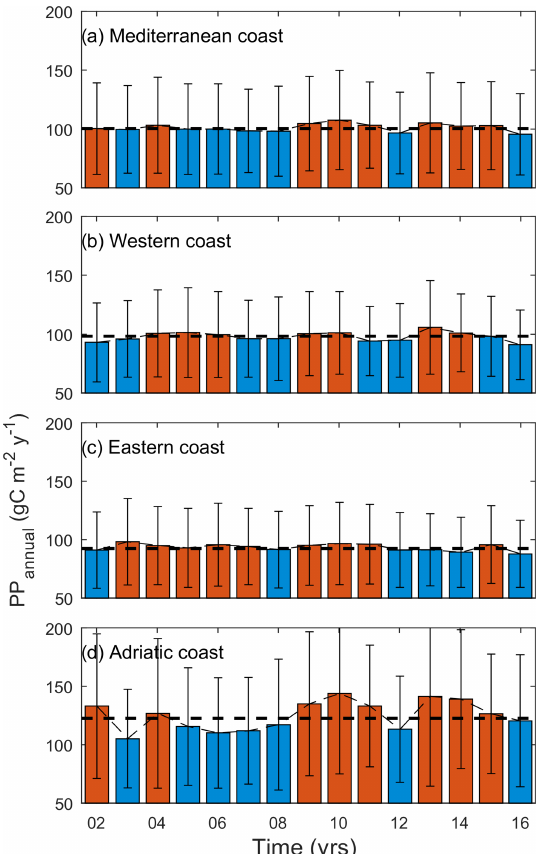
Figure A2. Annual mean coastal variations, PP annual (gCm − 2 yr − 1 ), for (a) the whole Mediterranean Sea, (b) the western basin, (c) the eastern basin, and (d) the Adriatic basin. Dashed black lines indicate the coastal mean PP annual at each study region. Red and blue bars indicate years above and below average values, respectively.